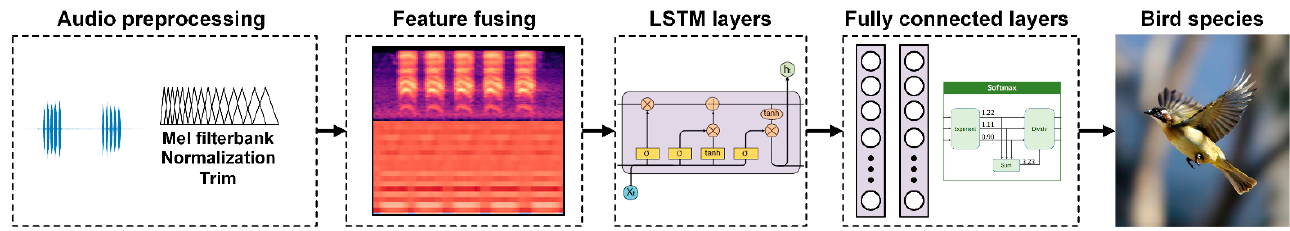
(Figure 5). Instead of directly extracting features from spectrogram and MFCCs, LSTM leverages the temporal context to enhance identification performance.